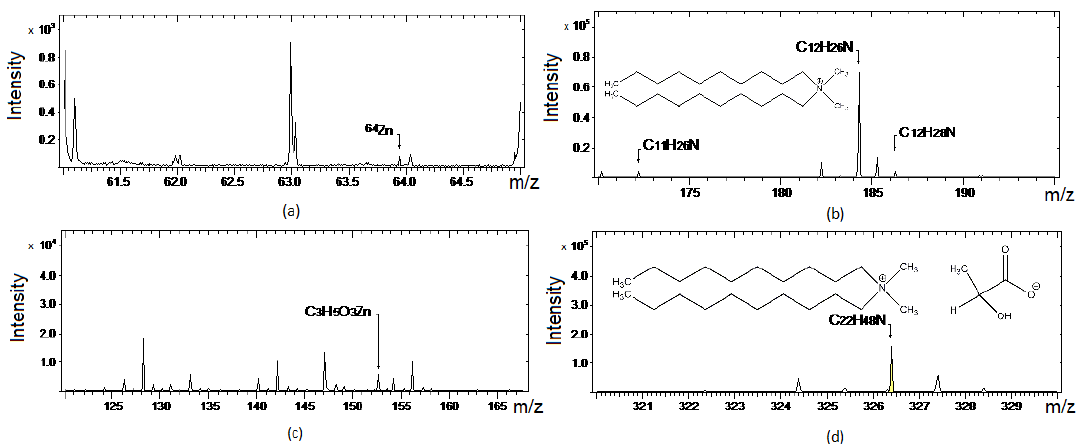
Figure 7. The secondary ion mass (TOF-SIMS) spectra for positive ions of DDALa and ZnO mixture: ( a ) Zn 2+ ; ( b ) C 12 H 26 N + , C 12 H 28 N + ; ( c ) C 3 H 5 O 3 Zn + ; ( d ) C 22 H 48 N + .